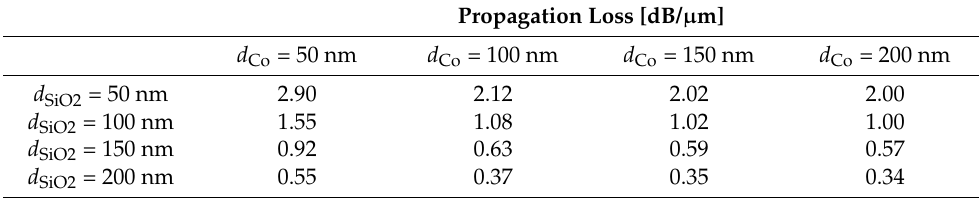
Table 1. Calculated propagation loss in a unit of dB/ µ m with combinations of different SiO 2 buffer layer thickness d SiO2 and Co layer thickness d Co for fixed Si core layer thickness of 250 nm and wavelength of 1550 nm.